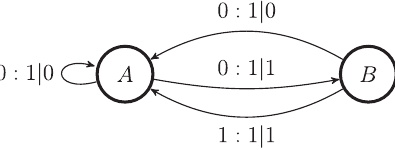
FIG. 2. Agents generally need to discard junk information. Hidden Markov model representation of the example process for Theorem 2. Nodes represent states and edges transitions; the notation y ∶ p j x denotes that on input stimulus x the indicated transition occurs with probability p whilst outputting action y . The strategy requires two internal states f A; B g , two stimuli f 0 ; 1 g , and two actions f 0 ; 1 g . On stimulus 0, both states enact 0 with certainty and transition to state A ; on stimulus 1, state A acts with 0 and transitions to B , while state B acts with 1 and transitions to A